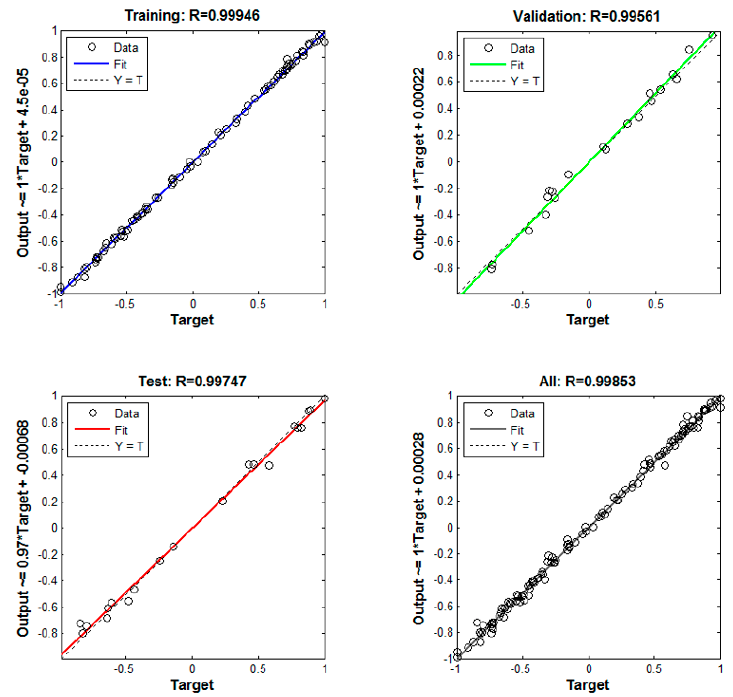
Figure 9. Performances of linear regressions.